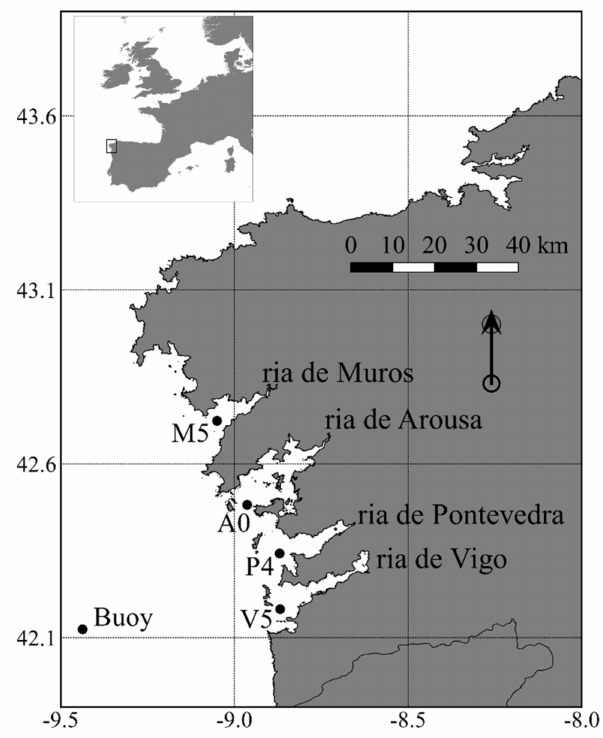
Figure 1. The Rias Baixas (Muros, Arousa, Pontevedra and Vigo) are located on the SW coast of Galicia (NW of the Iberian Peninsula). Locations of the stations used for this study (M5, A0, P4, V5 and Buoy of Cabo Silleiro) are